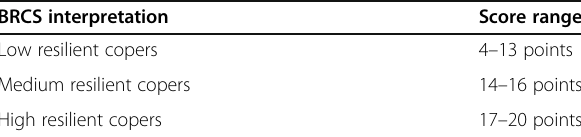
Table 2 BRCS interpretation and